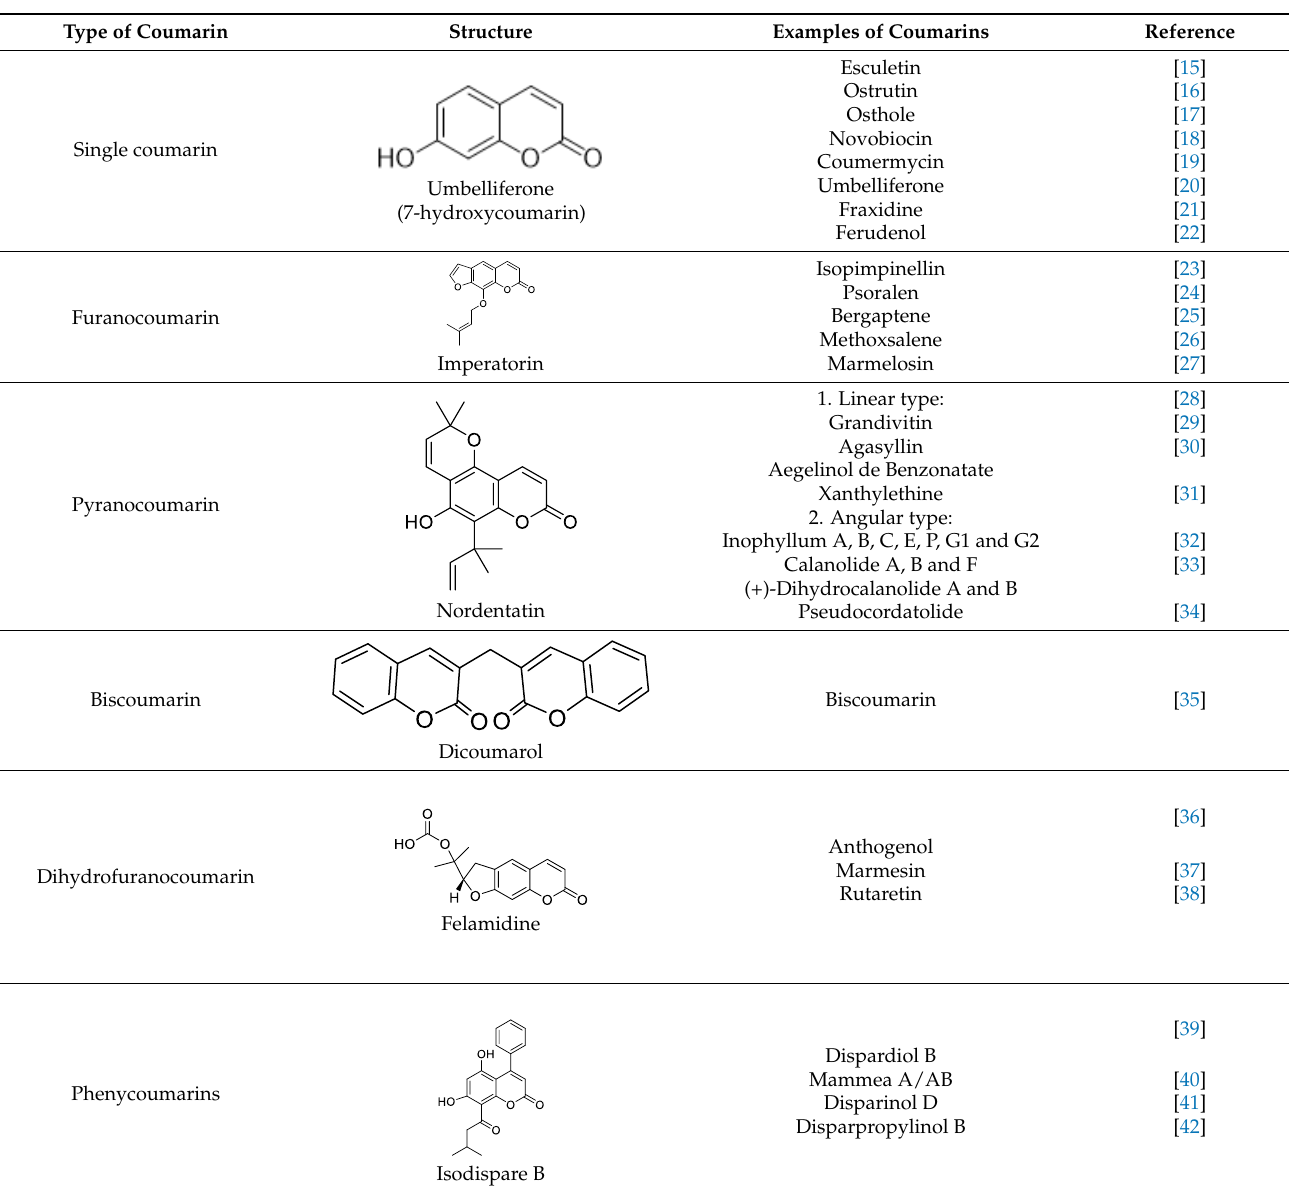
Table 1. Main structures of coumarins.